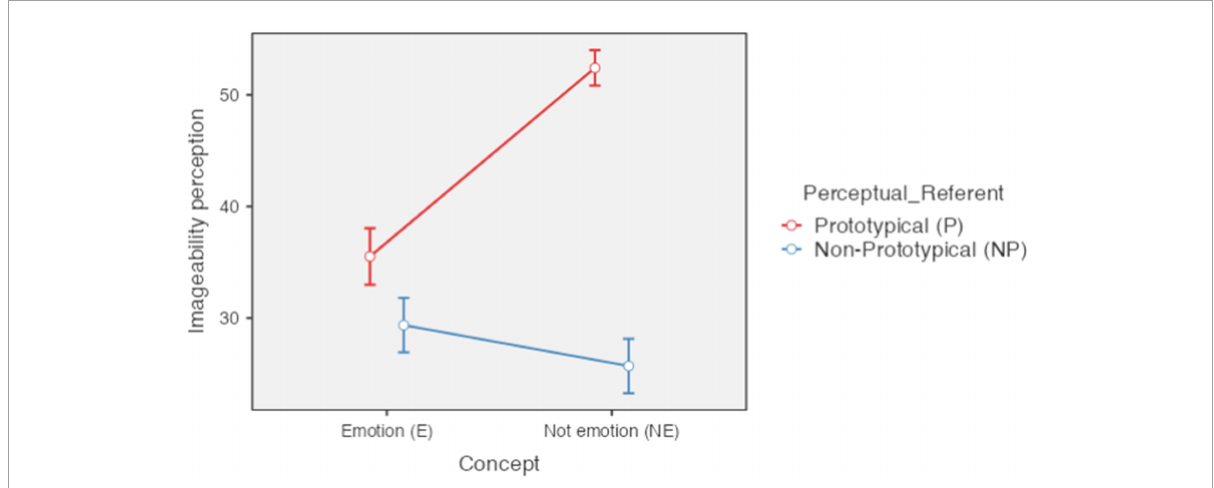
FIGURE2 Perception of imageability according to type of concept and type of perceptual referent. Error bars 95% CI; significant differences between concepts of, basic and secondary emotion (E-P_E-NP); basic emotion and concrete (E-P_E-NP); basic emotion and abstract (E-P_NE-NP; secondary emotion and concrete (E-NP_NE-P). P < 0.001. Created with Jamovi